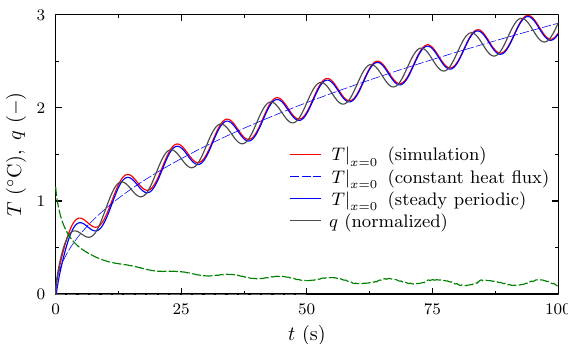
Fig. 8. Temperature response on the surface of a semi-infinite body made from stainless steel. The amplitude of the tem- perature oscillations is 1000 Wm − 2 , and the mean value is 2000 Wm − 2 . The heat transfer coe ffi cient at the interface is zero. The red line represents the numerical simulation, in comparison with the steady periodic oscillations (blue). The green line slowly approaching a zero value represents the di ff erence between them, magnified by a factor of 10. The gray line represents the heat flux oscillating around the constant mean